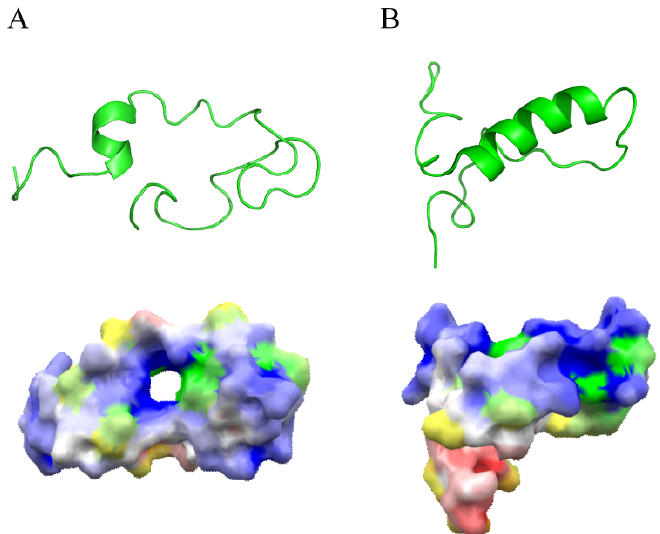
Figure 1. Structure of lactoferricin. ( A ) Representative structure and electrostatic surface display of lactoferricin in aqueous solvent (PDB accession, 1Z6W). ( B ) Representative structure and electrostatic surface display of lactoferricin with a distinct α -helix in membrane-mimetic solvent (PDB accession, 1Z6V). The negatively charged surface is shown in red, and the positively charged surface in blue. The molecular surface corresponding to the hydrophobic residues was also indicated by addition of yellow color to the electrostatic potential color; hence, orange color indicates hydrophobic and negatively charged surface; yellow color shows hydrophobic and neutral surface; green color indicates hydrophobic and positively charged